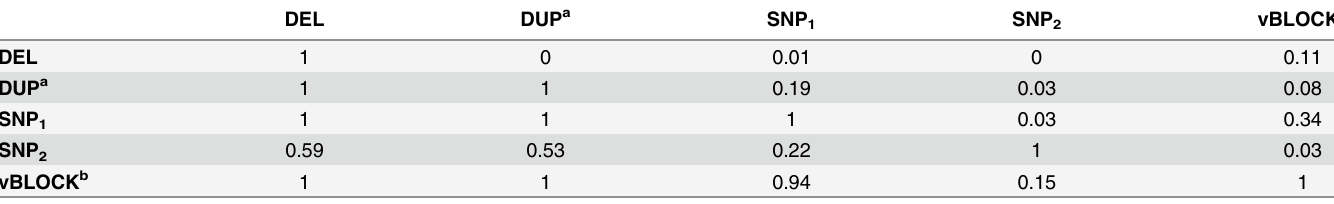
Table 2. LD c between the loci altering mean leaf molybdenum concentrations.